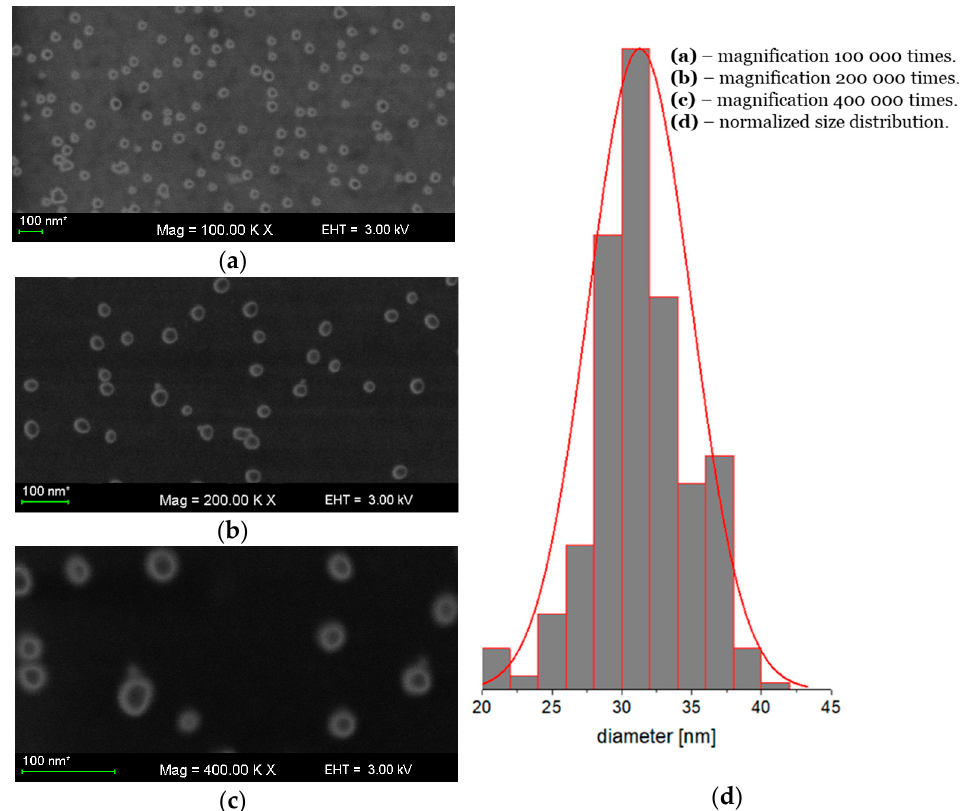
Figure 2. SEM images of AgNPs nanoparticles monolayer on PEI-modified silica wafers with various magnifications, and their normalized size distribution at N = 500 (D). ( a ) 100 KX; ( b ) 200 KX; ( c ) 400 KX; ( d ) AgNPs size distribution.